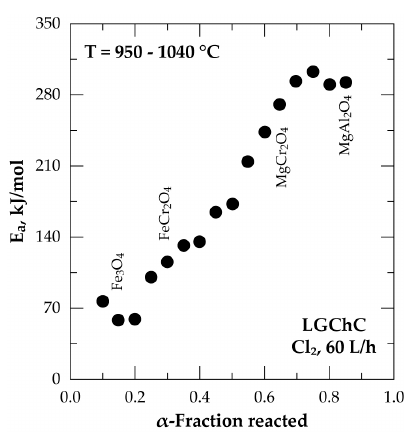
Figure 10. Plot of the apparent activation energy (E a ) versus fraction reacted for the treatment of LGChC in chlorine atmosphere between 950–1040 °C.